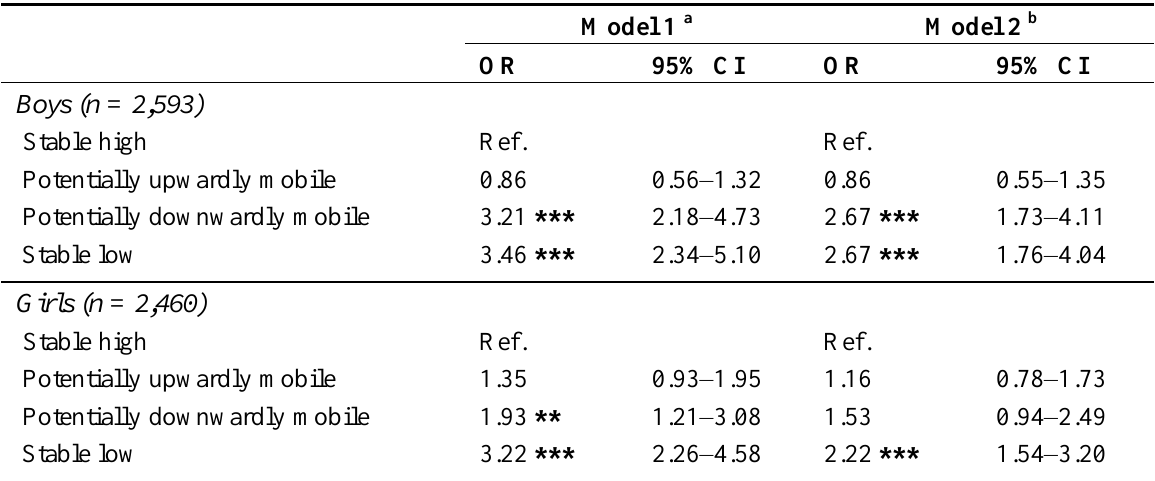
Table 4. Logistic regression analyses of intergenerational educational mobility and smoking among 12- to